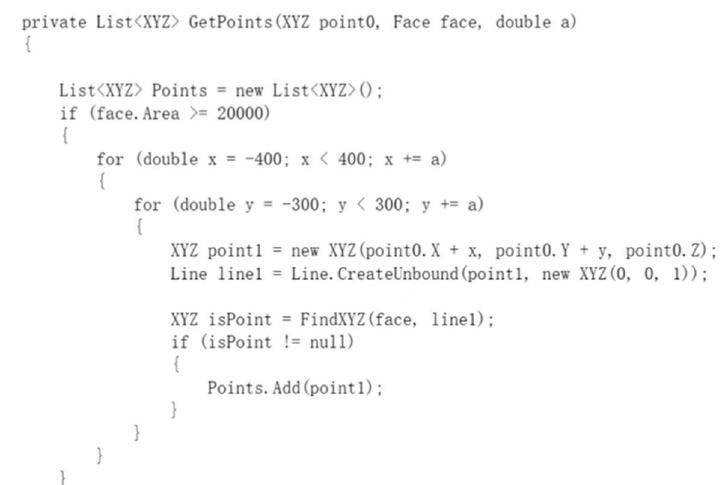
Fig. 7 Key code of laying the measuring